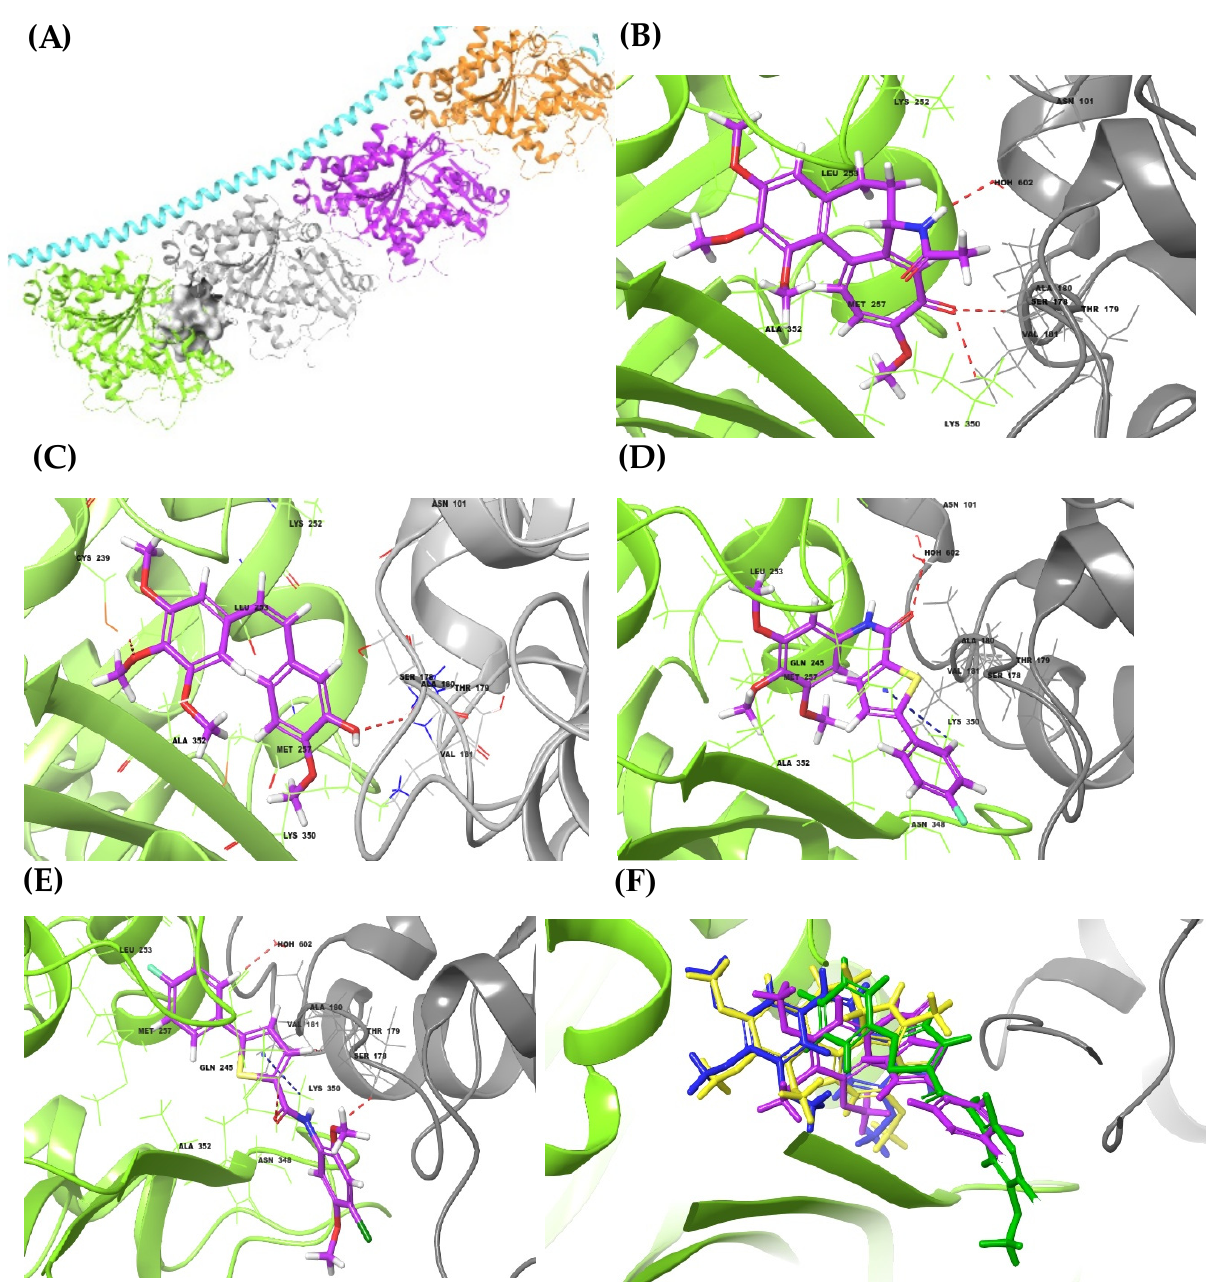
Figure 4. ( A ) The 3D-structure of tubulin protein (PDB ID: 6XER), chain A (orange), chain B (purple), chain C (gray), chain D (light green), and chain E (light blue); the colchicine-binding pocket is shown as a gray surface. Figures ( B – E ) represent the molecular docking simulations of colchicine, CA-4 compound, 2b compound, and 2e compound within the tubulin-binding site. The hydrogen bond and π -cationic are represented by dashed red and blue colors, respectively. Figure ( F ) represents the superposing of the docked poses of colchicine (yellow), CA-4 (blue), 2b compound (purple), and 2e compound (green).